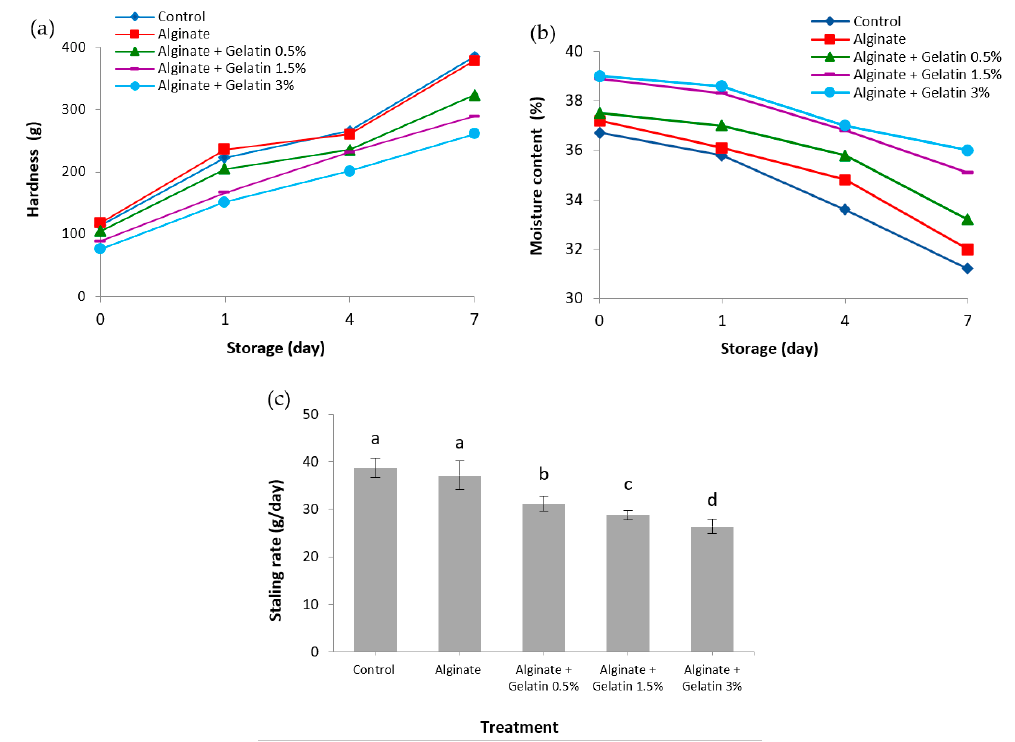
Figure 1. ( a ) The hardness, ( b ) moisture content, and ( c ) staling rate bread supplemented with encapsulated L. acidophilus in different matrices during storage. Means ± SD with different letters in the same column represent significantly different ( p > 0.05).